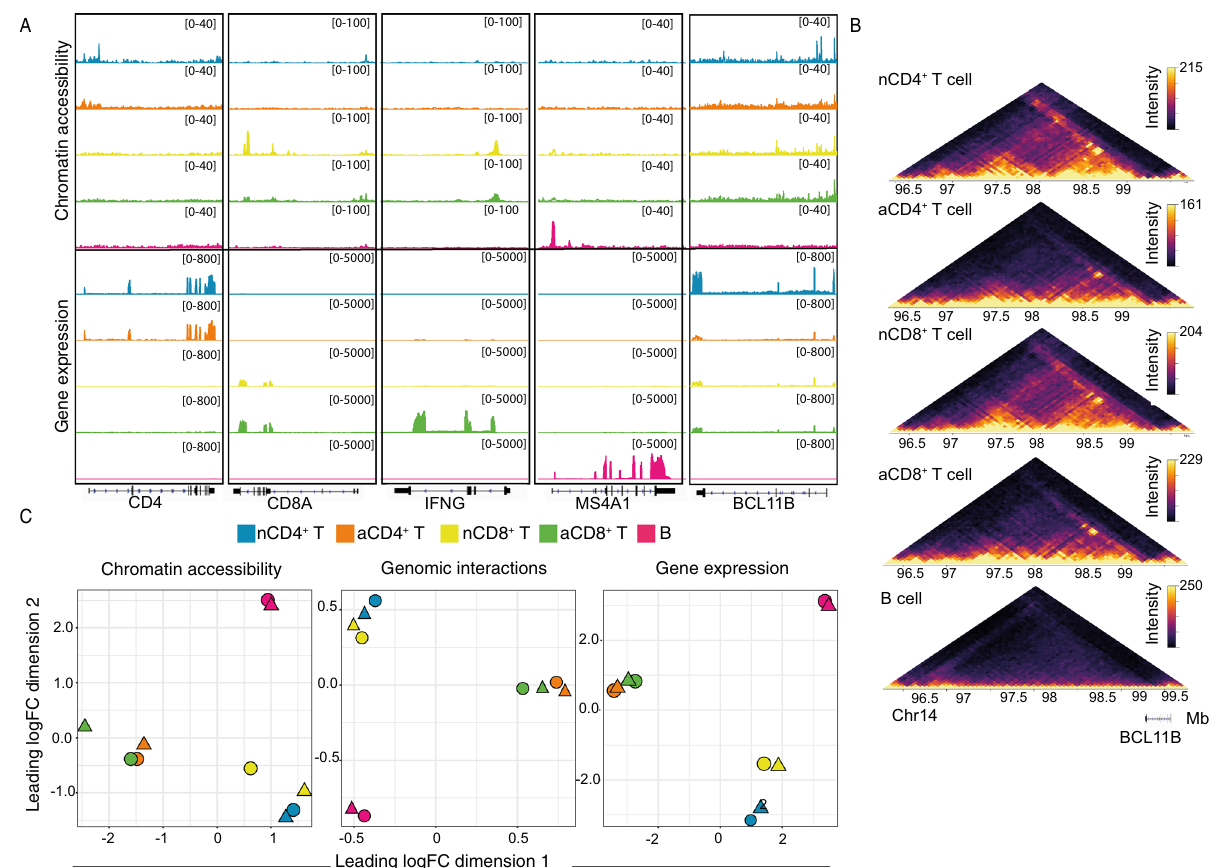
Figure 1. Chromatin structure and gene expression are immune cell type-specific. ( A ) Normalized read coverage plots of ATAC-seq and RNA-seq libraries at phenotype-defining genes including CD4 , CD8A, IFNG, MS4A1 and BCL11B loci in resting CD4 + (nCD4 + ), resting CD8 + (nCD8 + ), activated CD4 + (aCD4 + ), activated CD8 + (aCD8 + ) T and resting B ( B ) cells. ( B ) In-situ Hi-C contact matrices for a 1 Mb region on chromosome 14 that includes BCL11B, which is known to be expressed in T but not B cells. The top four Hi-C matrices display data from resting and activated T cells and show distinct genome organisation at the gene, while the bottom Hi-C matrix of B cells shows a lack of genome organisation at BCL11B. Color scale indicates number of reads per bin pair and has been scaled within each matrix to facilitate comparisons. ( C ) Multidimenional scaling (MDS) plots of log-CPM values with samples coloured by cell type and shaped by donors. The log-CPM values were corrected for the donor variable. Distances on the plot correspond to the leading fold-change, which is the average (root-mean-square) log2-fold-change for the 500 genes (RNA-seq), 5000 peaks (ATAC-seq) and 50,000), bin pairs (Hi-C) most divergent between each pair of